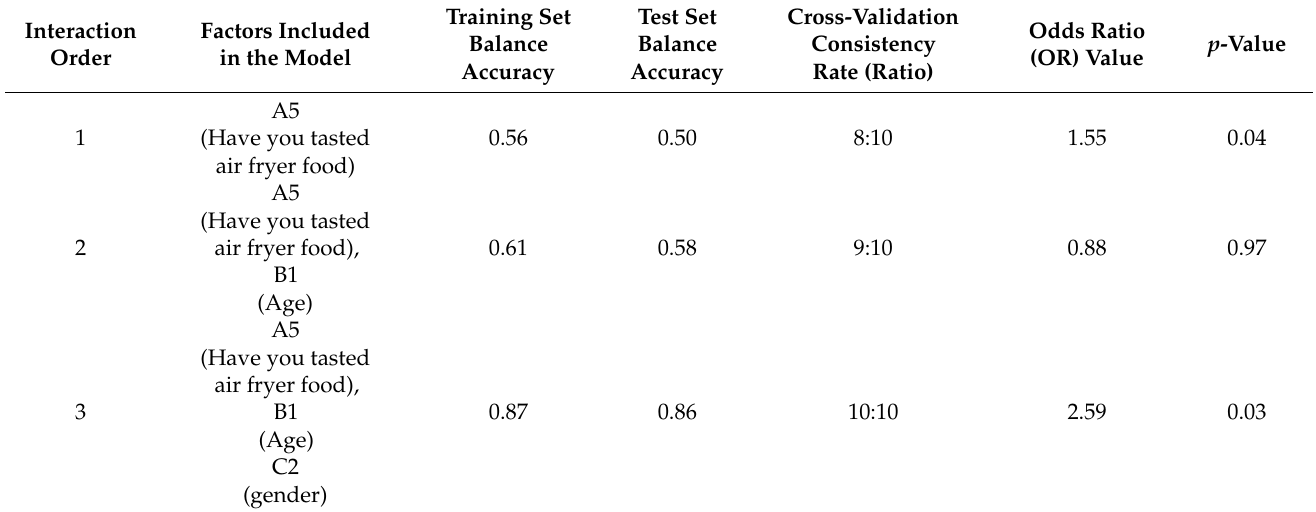
Table 5. Determination of the best model of MDR, a total of 11 variables and 660 recorded data points were screened out according to the basic information of the interviewees and imported into the MDR software, after fitting all the models in the 1–3 interaction order.